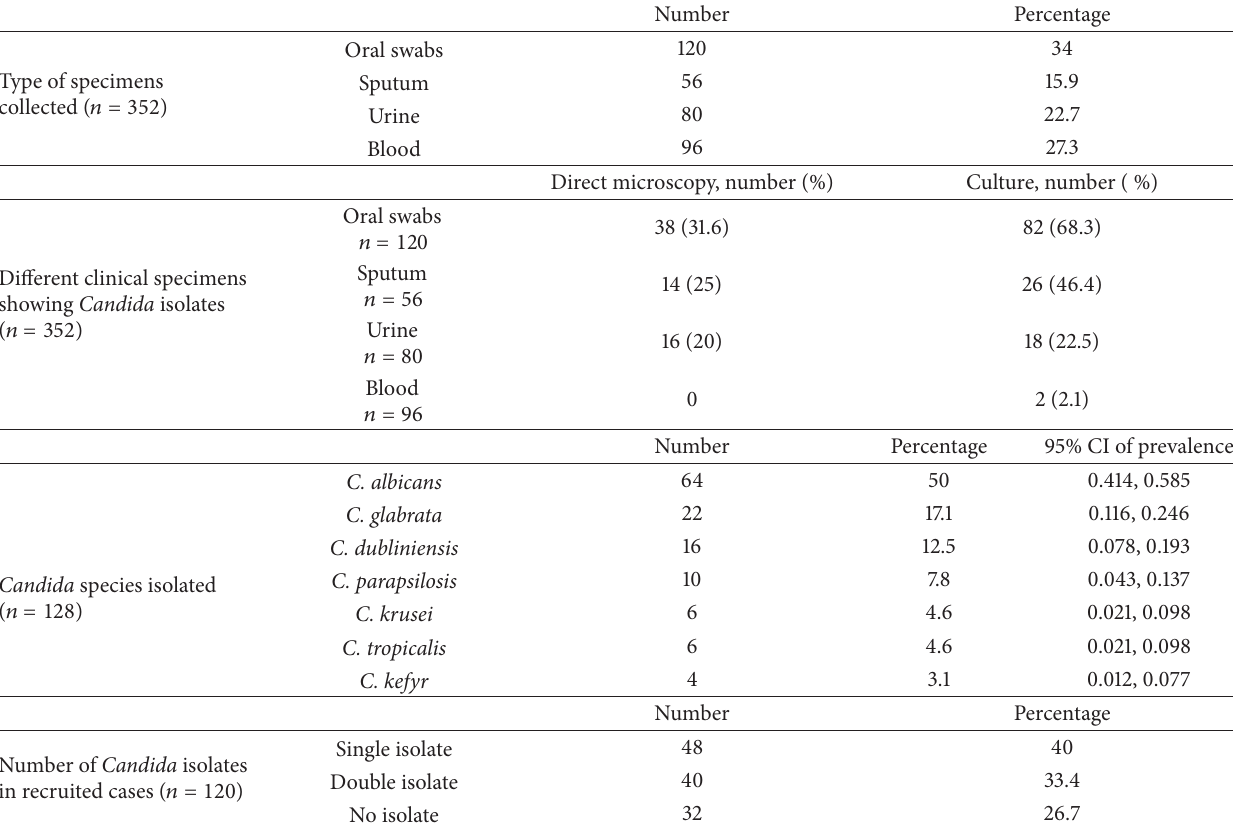
Table 4: Sample distribution and Candida profile of study subjects. 𝑛 = 120